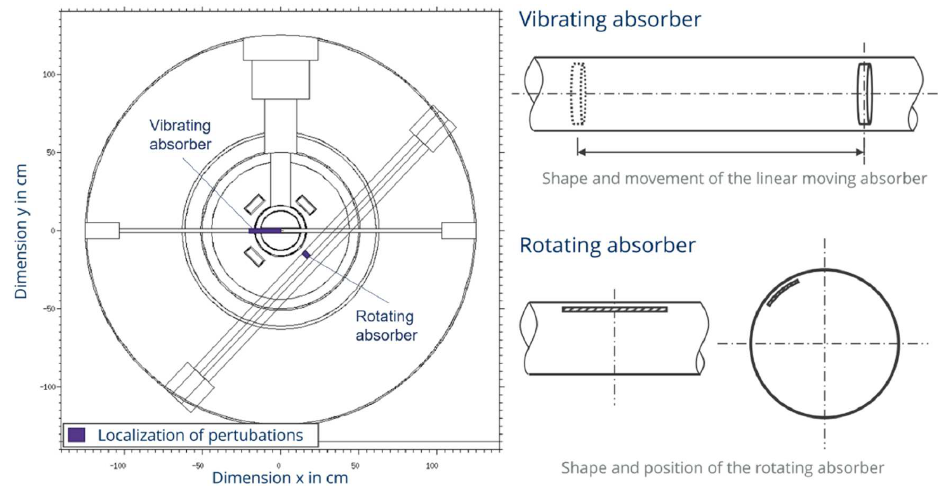
Fig. 8. Vibrating and rotating modulators in the AKR-2 reactor (after [10]).